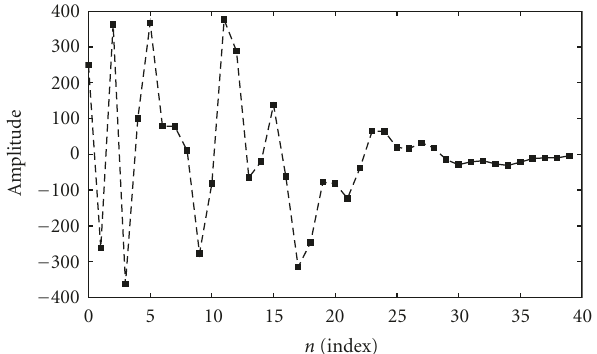
Figure 5: One excitation pulse of the LPC-10 coder